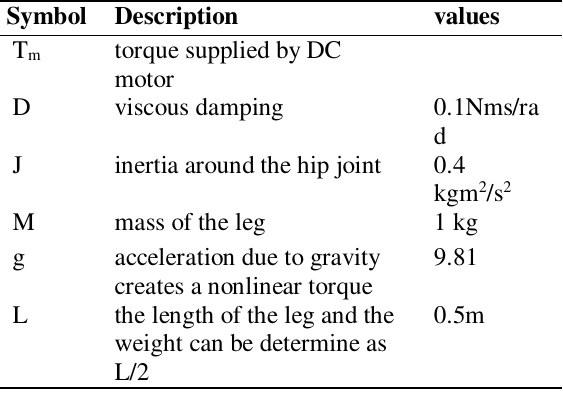
The parameters of human robotic leg model.